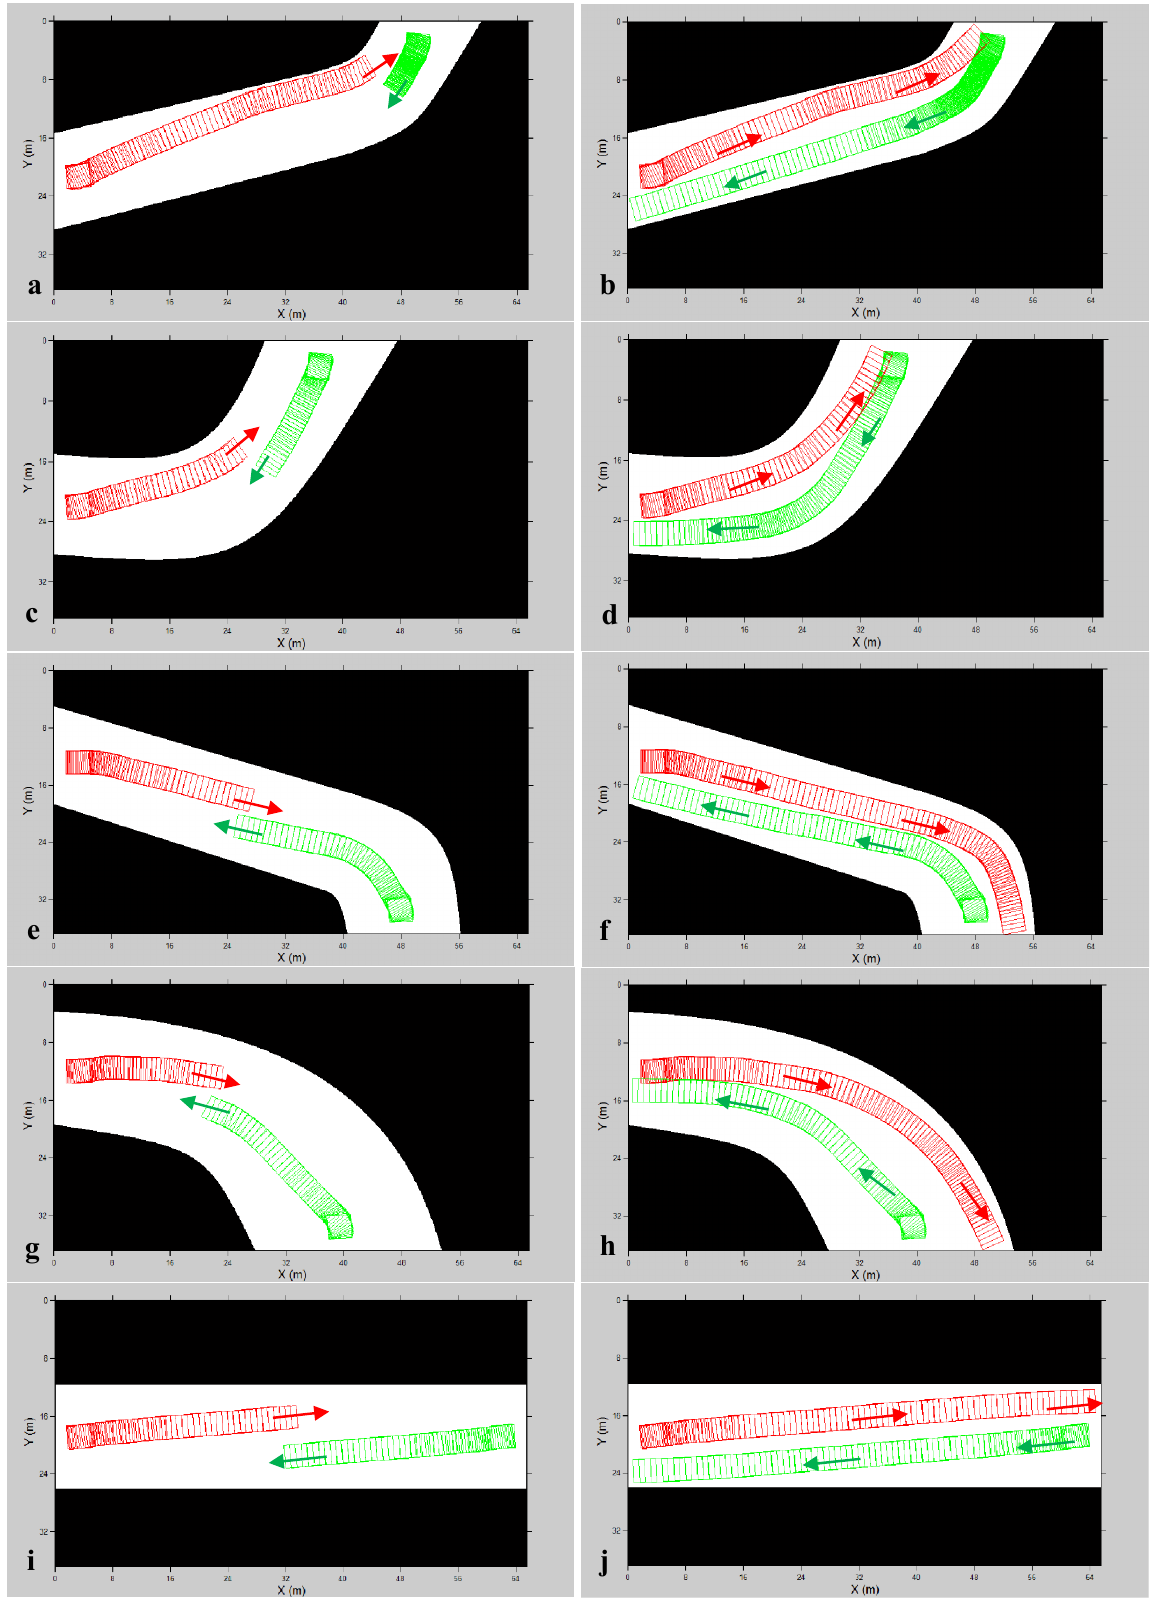
Figure 11. Simulation results with two vehicles. ( a ) First Left Turn Scenario (midway); ( b ) First Left Turn Scenario (end of simulation); ( c ) Second Left Turn Scenario (midway); ( d ) Second Left Turn Scenario (end of simulation); ( e ) First Right Turn Scenario